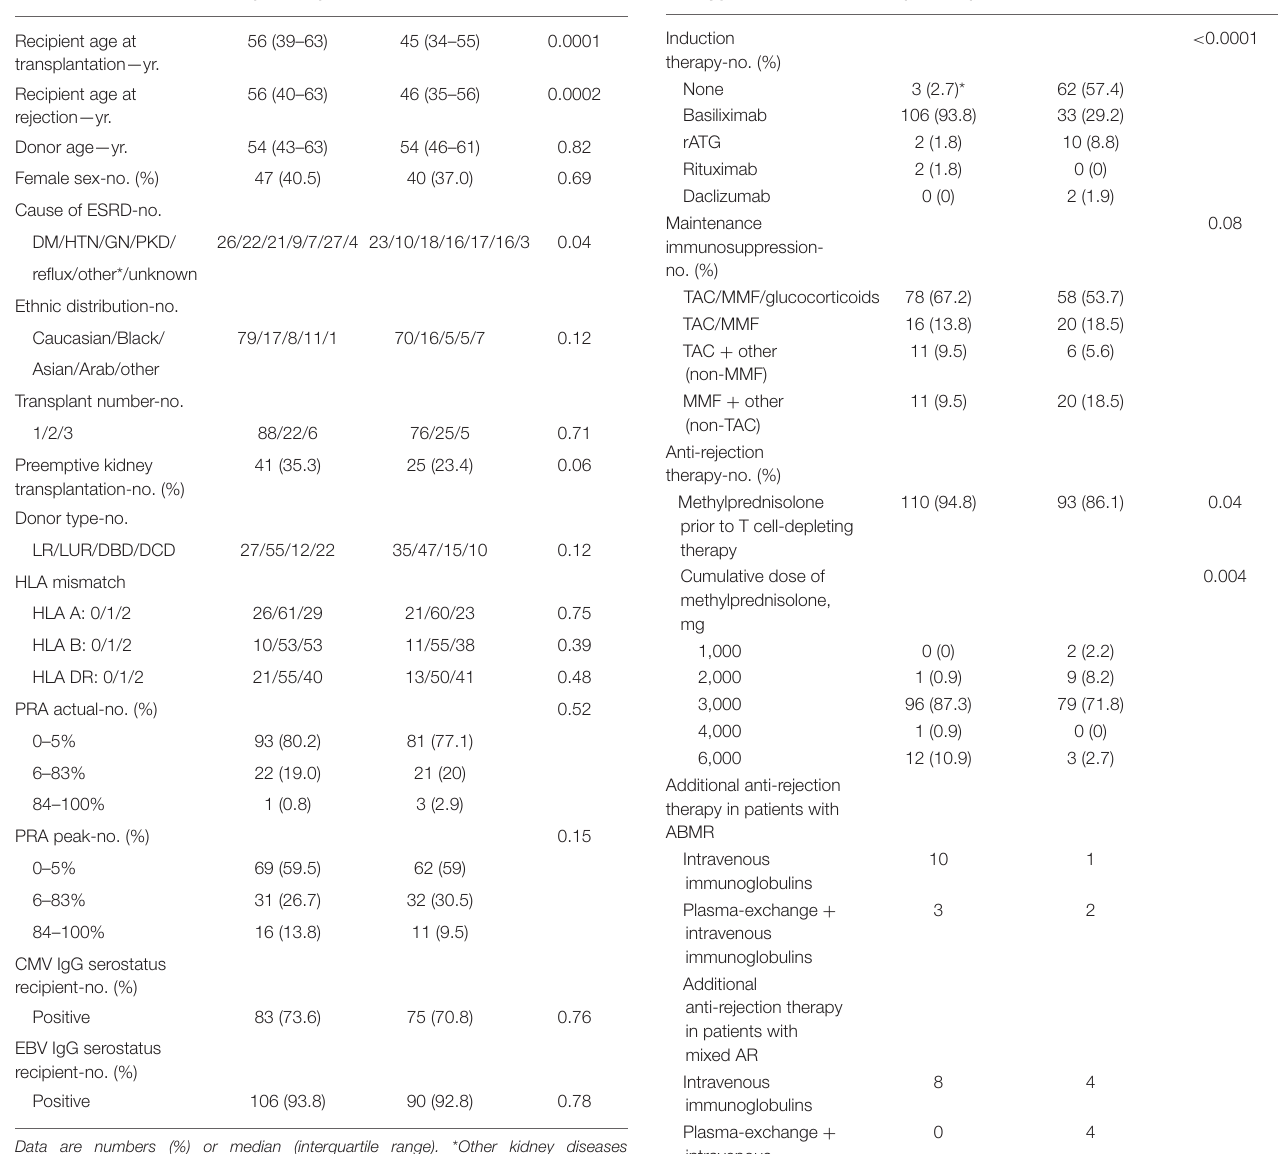
TABLE 2 | Immunosuppressive therapy in patients treated with alemtuzumab or rATG. Immunosuppressive therapy Induction therapy-no.